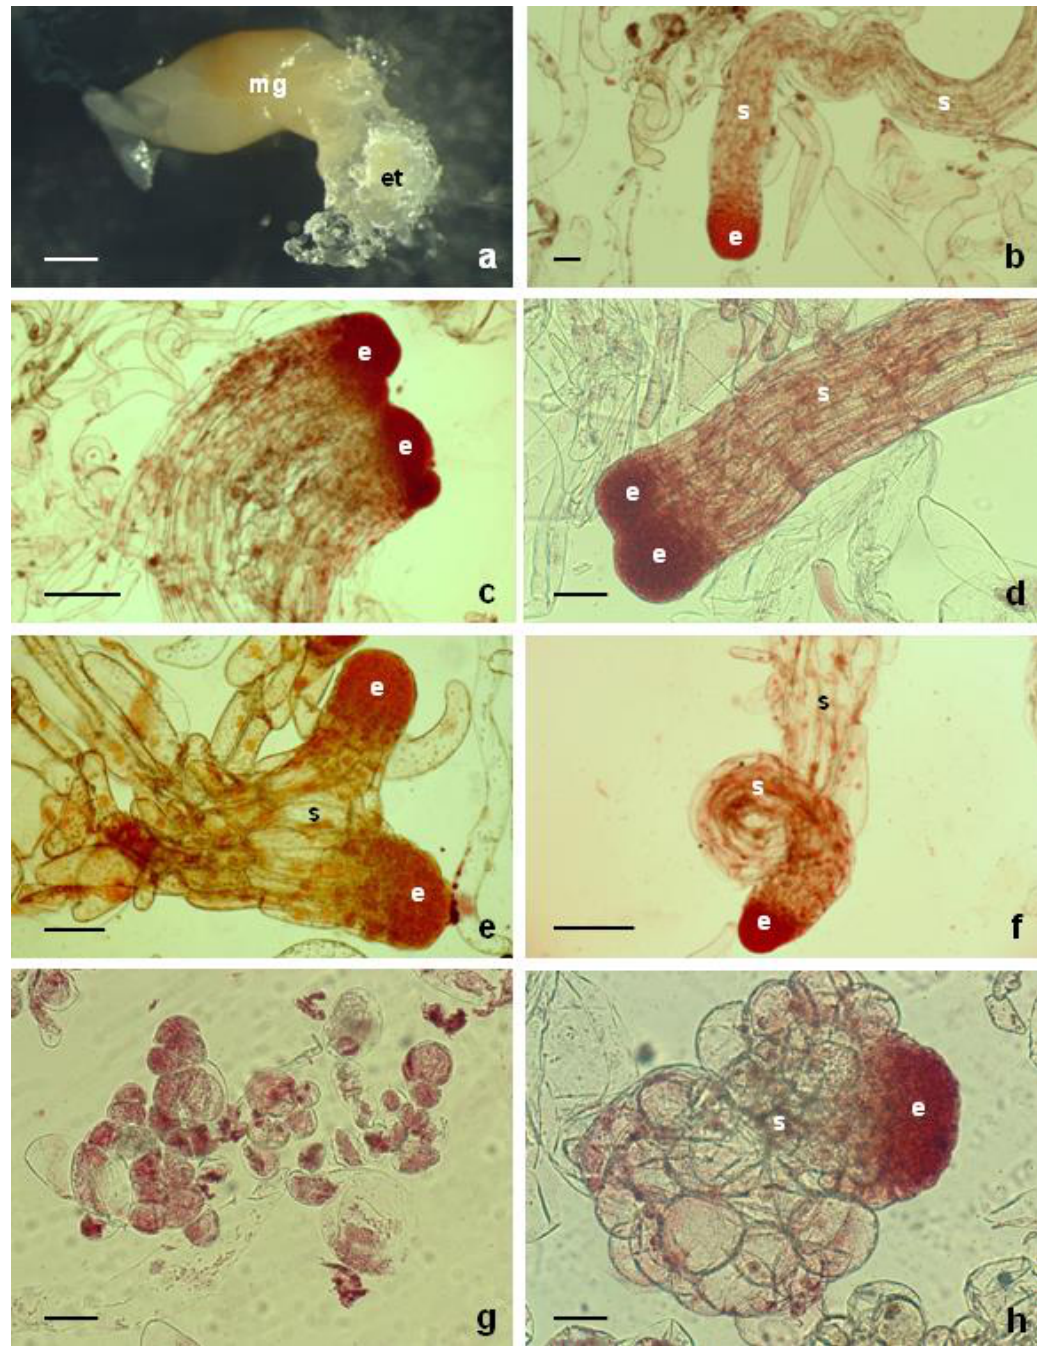
Figure 1. Initiation of somatic embryogenesis and structural characterization of embryogenic tissue in Abies alba : ( a ) extrusion of embryogenic tissue (et) from megagametophyte explant (mg), ( b ) bipolar somatic embryo with embryonal meristematic cells (e) and long vacuolized suspensor cells (s), ( c ) polyembryonal complex observable in embryogenic tissue, ( d ) twin somatic embryo, ( e ) somatic embryos with branched suspensor (s), ( f ) curling of suspensor (s) of a somatic embryo; ( g ) unorganized cell mass observed in tissue that lost the embryogenic character, ( h ) somatic embryo with changed micromorphology after five years of maintenance on a proliferation medium. Bars: a—1000 µm; ( b , d , e , g , h ) 200 µm; ( c , f ) 500 µm.